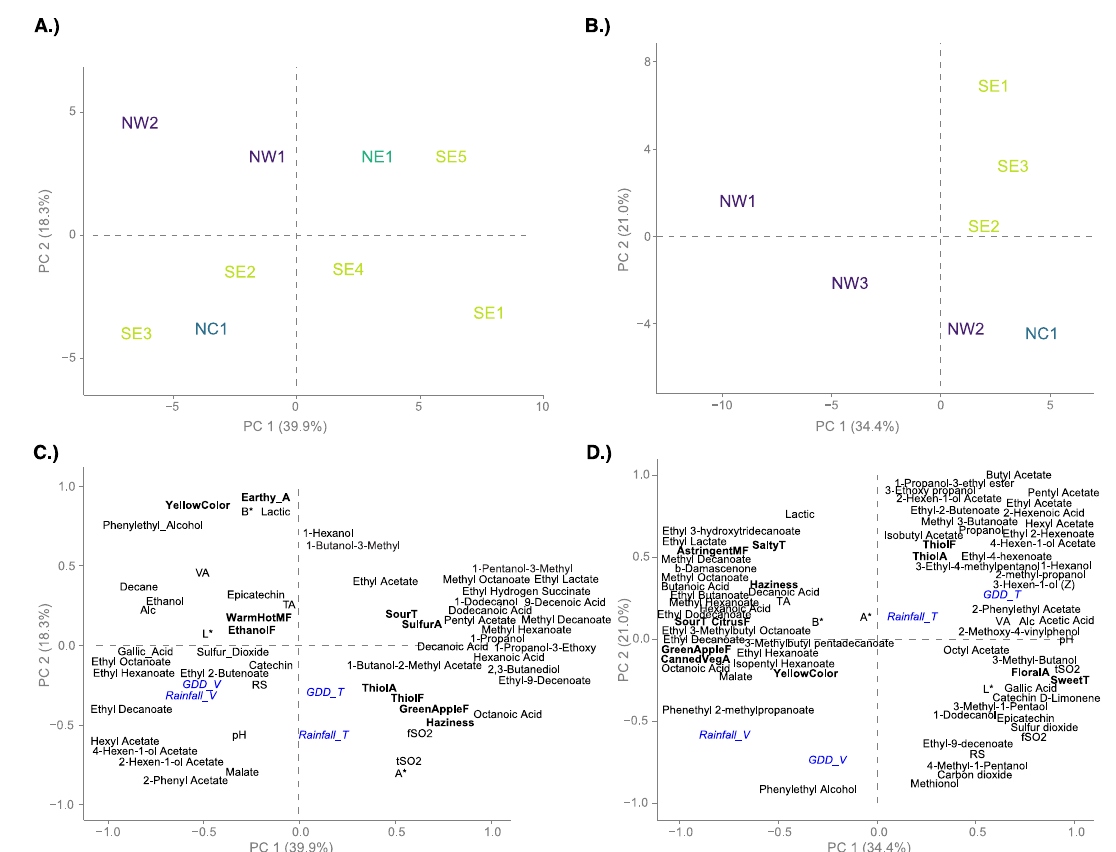
Figure 4. Principal component analysis (PCA) results for wine samples ( A , B ) and sensory and chemical variables ( C , D ) for Year 1 ( A , C ) and Year 2 ( B , D ) results. Rainfall and GDD data shown in blue were superimposed as supplementary variables onto the PCA and quantified in two ways: véraison to harvest (_V) and total (_T) values. See Tables S6 and S8 for variable loadings.